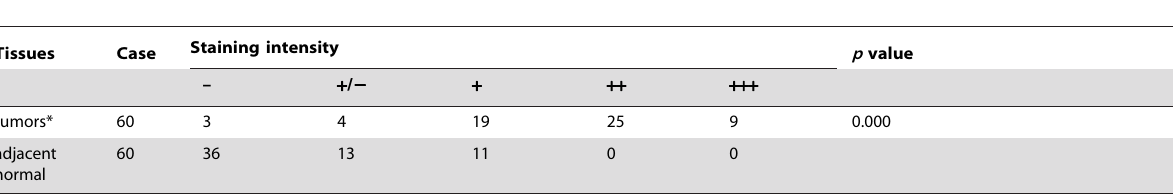
Table 1. In situ hybridization of MALAT1 in human CRC tissues.